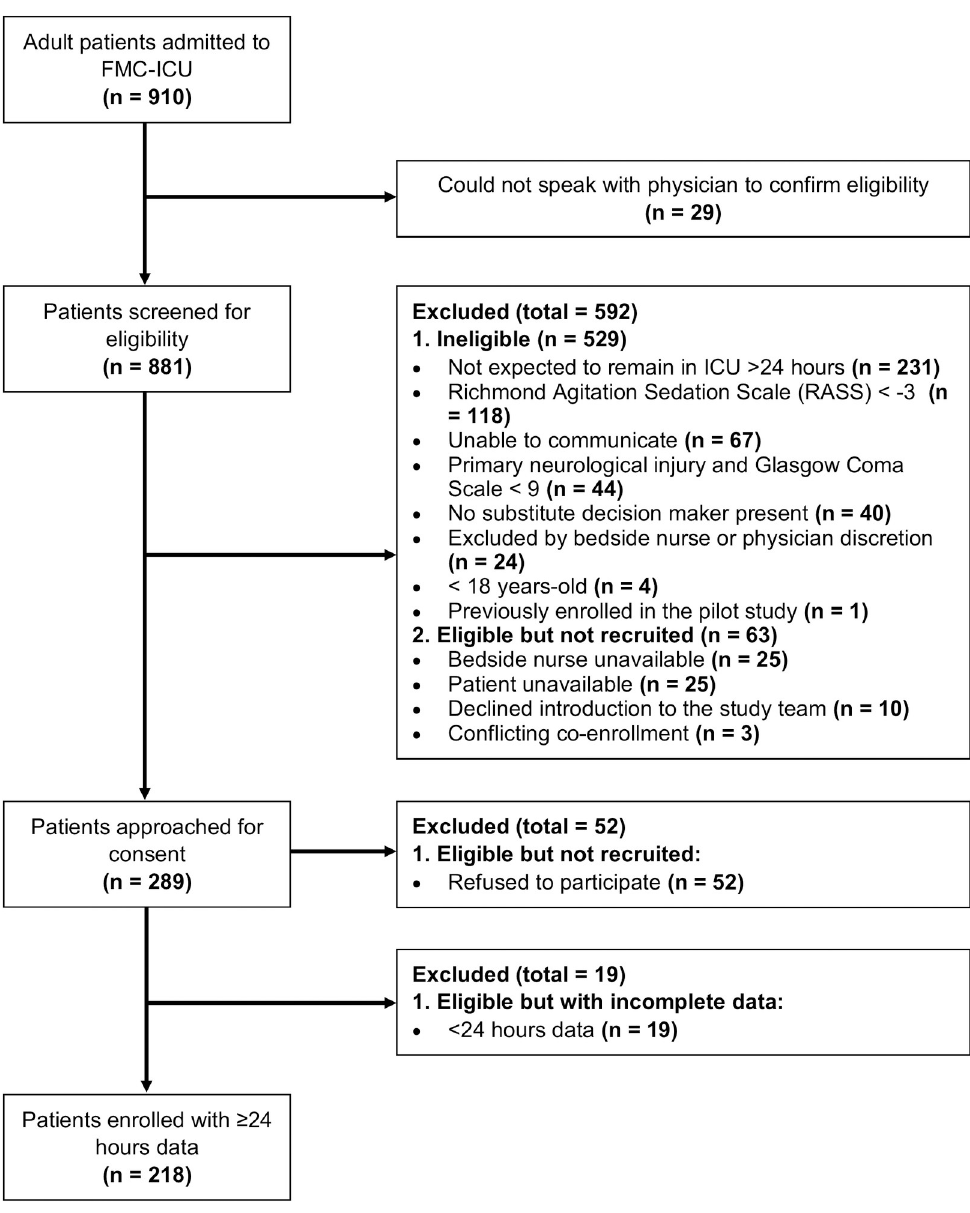
Fig 1. Patient participant flow